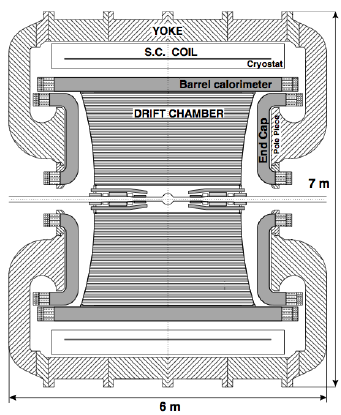
Figure 1. Vertical cross-section of the KLOE detector along the beam